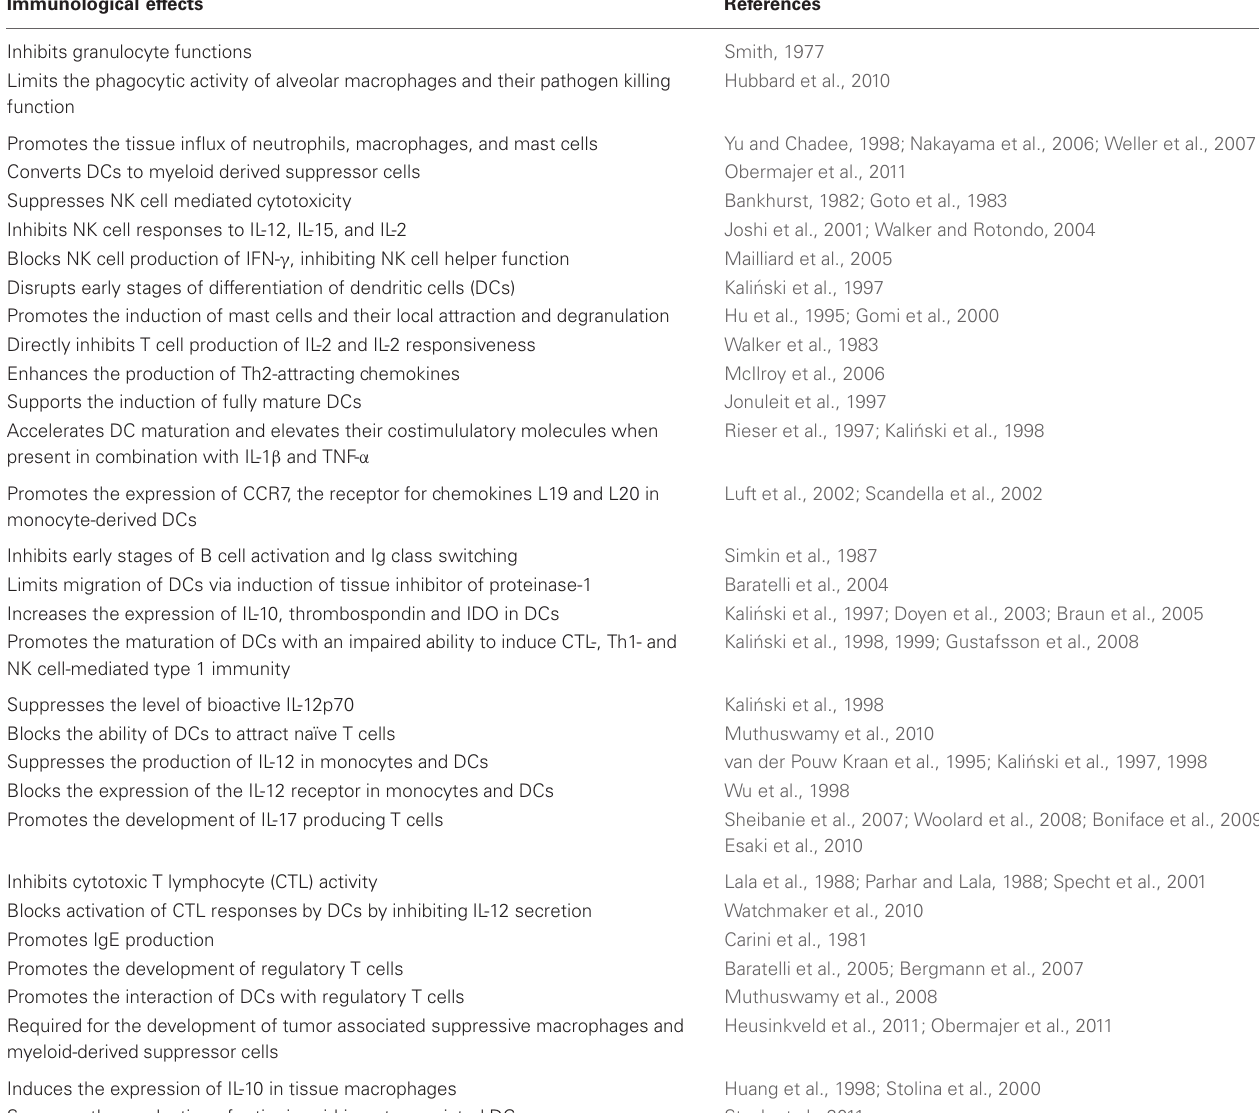
Table 2 | Effects of PGE 2 on immune